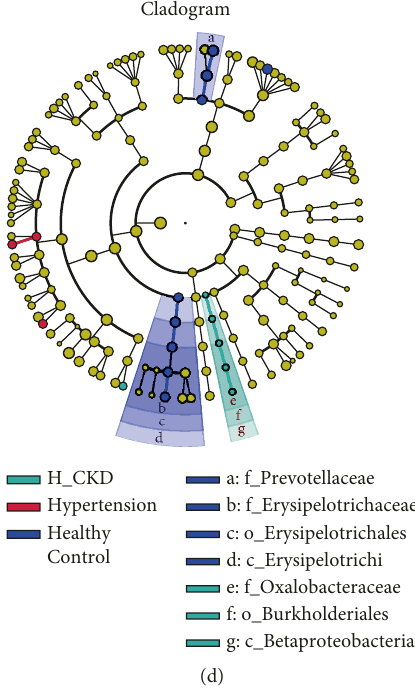
Figure 3: Characteristics of Gut Microbiota in the HC, hypertension and H-CKD. (a) Diagram of the LDA score at genus level between hypertension and HC; the enriched genus in hypertension is red, and blue in HC; (b) cladogram at genus level shows the original bacterial tree form the central point, the circles form inside to outside representing phylum to genus; The c-Bacteroidia is the main enriched in HC, and the c- Bacilli is the main enriched in hypertension; (c) diagram of the LDA score at genus levels among hypertension, H-CKD, and HC; the enriched genus is green in H-CKD, red in hypertension, and blue in HC; (d) cladogram at genus level shows the original bacterial tree form the central point, the circles form the inside to outside representing phylum to genus; the c-Erysirelattishi is the main enriched in HC, and the c- Betaproteobacteria is the main enriched in H-CKD. phylum to species: (p) phylum; (c) class; (o) order; (f) family; (g) genus; and (s)